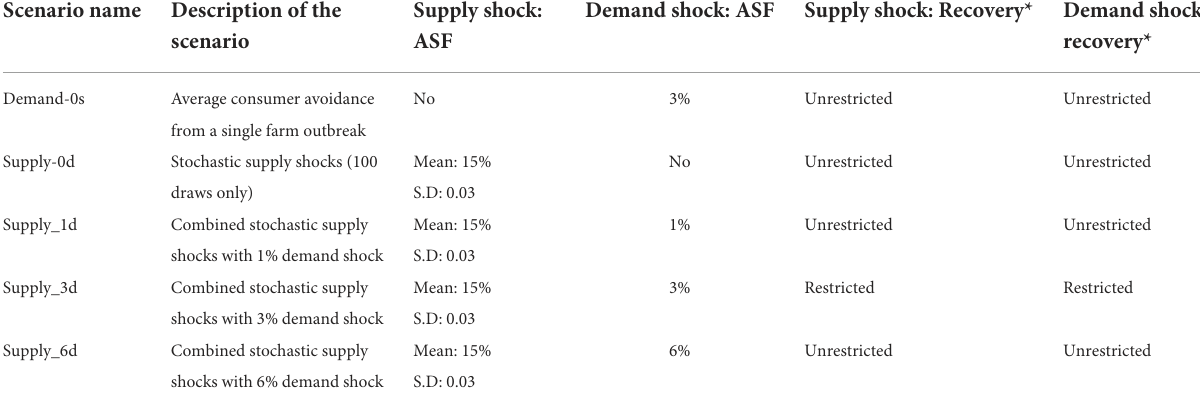
TABLE 3 Shock description for ASF prospective impacts.